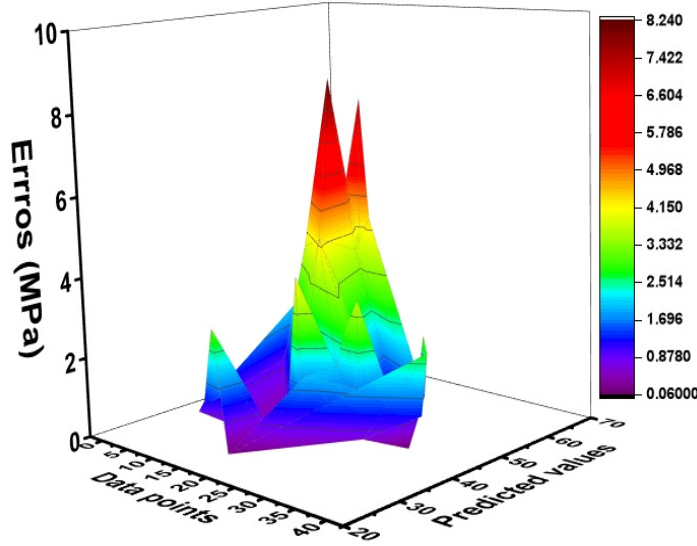
Figure 10. Error graphs of validation set of MEP model.